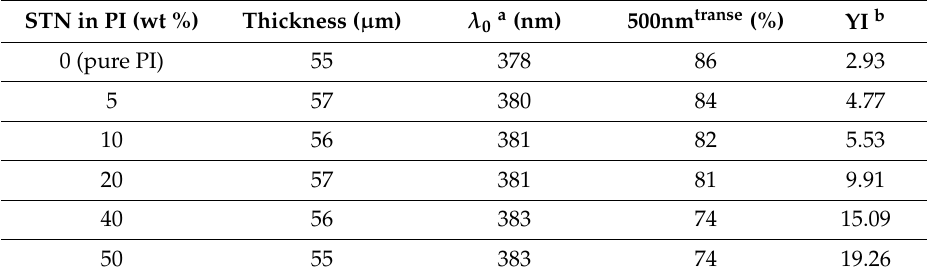
Table 6. Optical properties of the Co-PI hybrid films with varying STN concentrations. STN in PI (wt %)